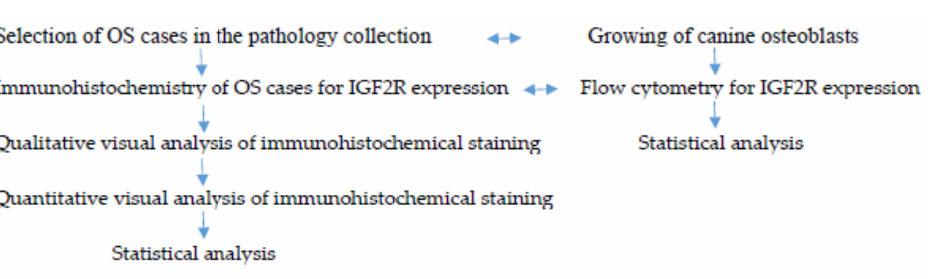
Figure 7. Workflow of the experiments. The IHC analysis of the clinical cases and the growth and flow cytometry of canine osteoblasts were conducted in flow cytometry of canine osteoblasts were conducted in parallel.